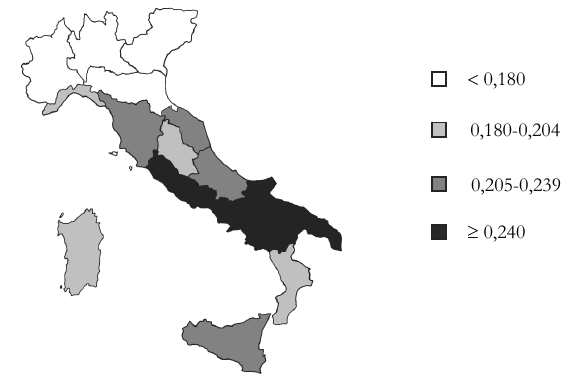
Figura 1c – Child mortality in the Italian regions,